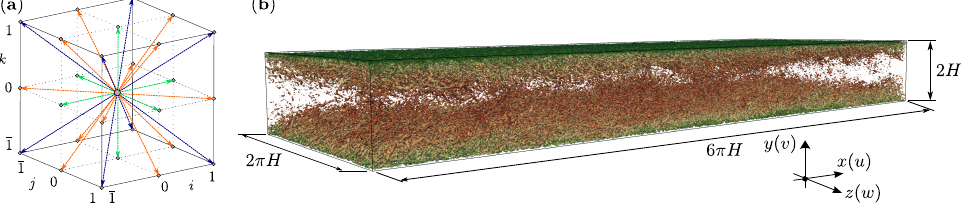
Figure 2. ( a ) Illustration of the employed D3Q27 discretization. ( b ) Dimensions of the investigated channel flow featuring isosurface snapshots of the Q -criterion [46], colored by the streamwise ( x - direction) velocity component for Re B ≈ 1.7 × 10 6 on a homogeneous Cartesian grid featuring approximately 27 million lattice nodes ( H / Λ H = N H =